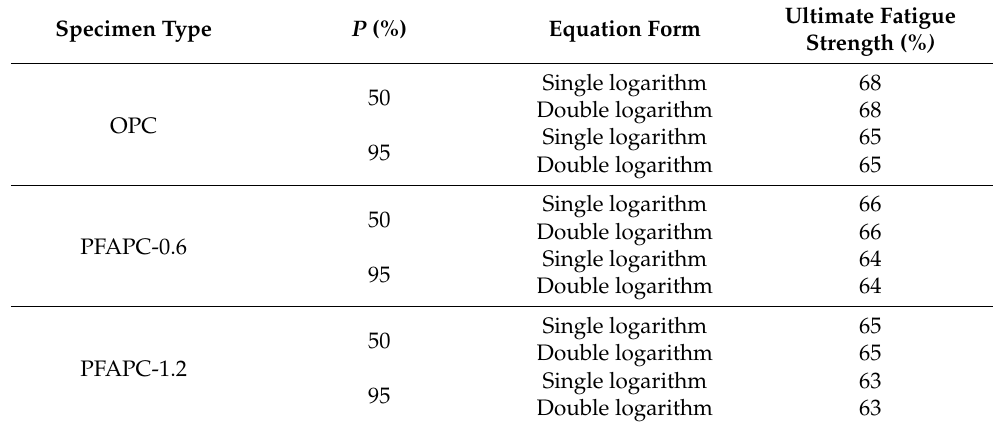
Table 10. Ultimate fatigue strength under two-parameter Weibull